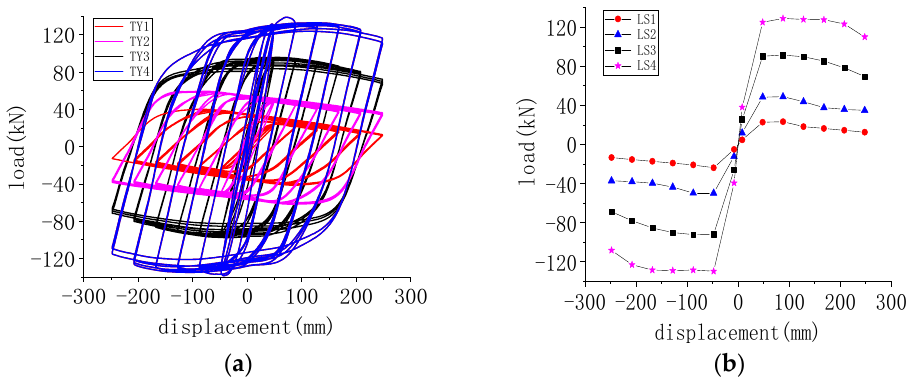
Figure 22. Hysteresis curve and skeleton curve of specimen LS: ( a ) hysteresis curve; ( b ) skeleton curve.